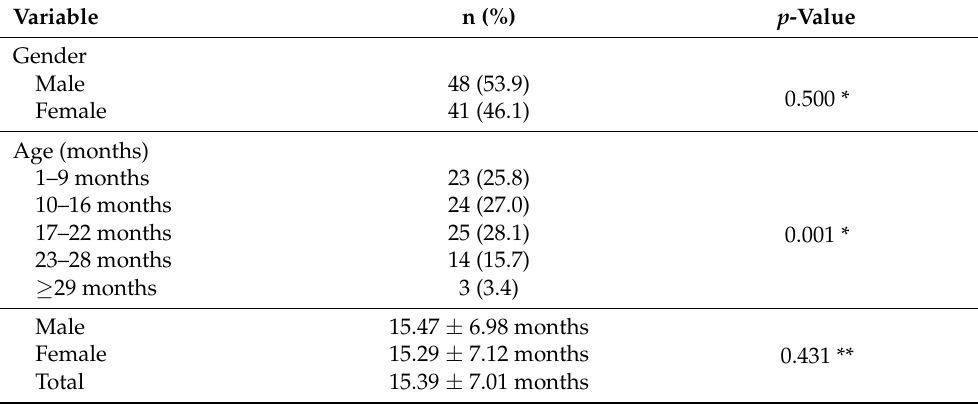
Table 1. Sociodemographic characteristics of studied children (n = 93).